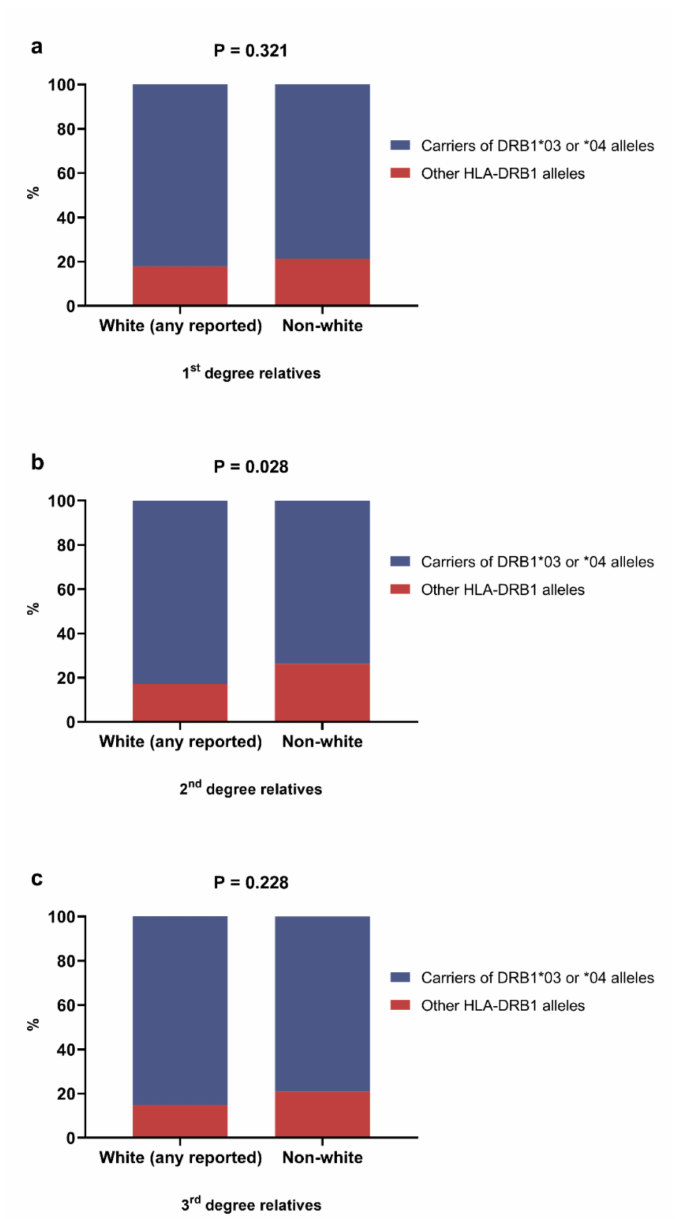
Figure 3. Distribution of carriers of HLA-DRB1*03 or/and 04 alleles according to reported race/skin color in 1st degree ( a ), 2nd degree ( b ) and 3rd degree ( c ) relatives. Chi-square test was performed for statistical